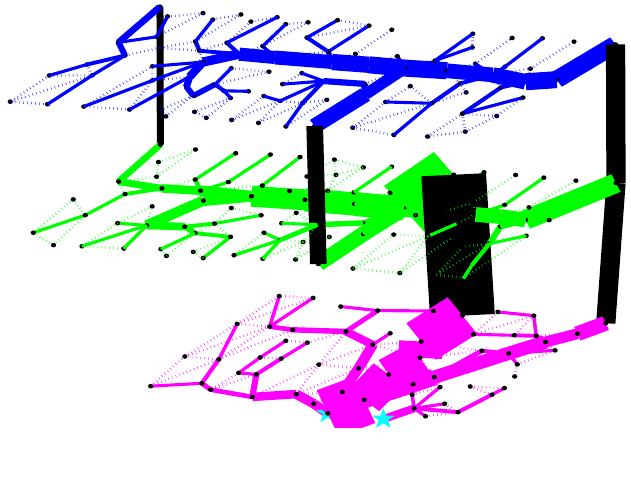
Figure 10. Dijkstra’s algorithm routing.